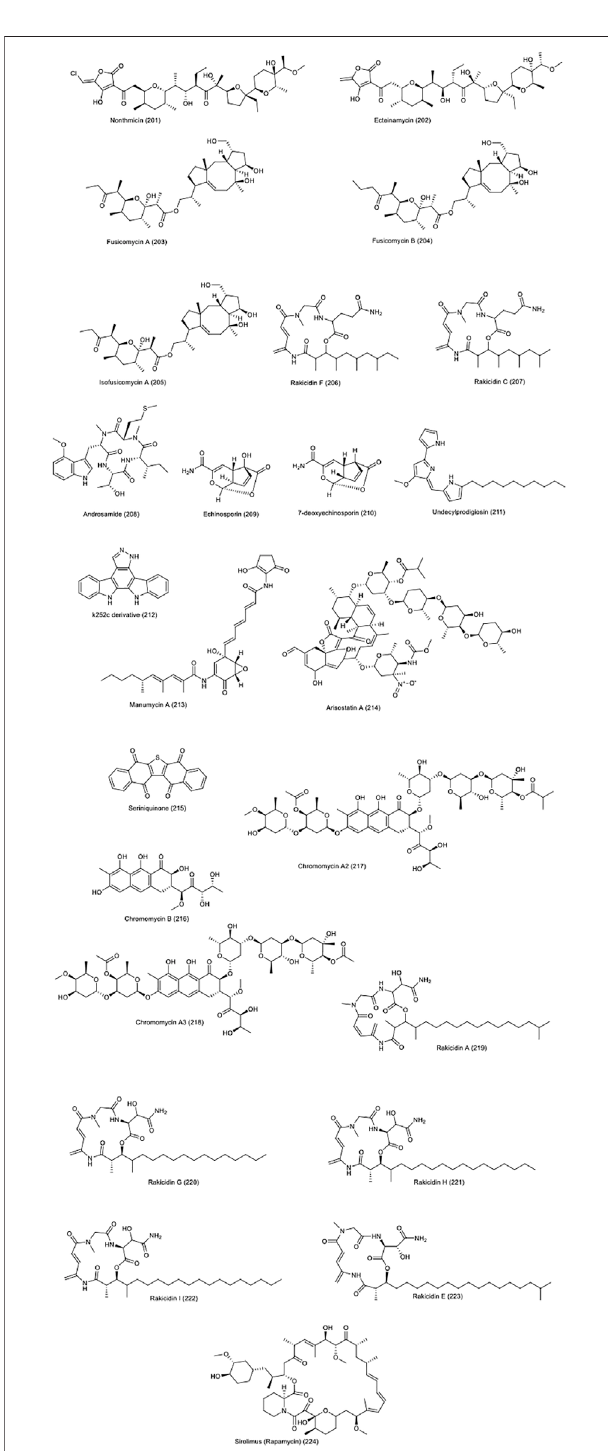
FIGURE 10 | Chemical structure of compounds presented in the Section 2 “ Potential biological mechanisms and function of NPs against CRC.